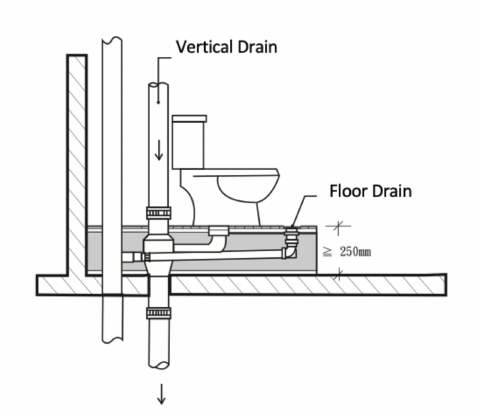
Figure 3. Schematic definition of the raised floor piping system.